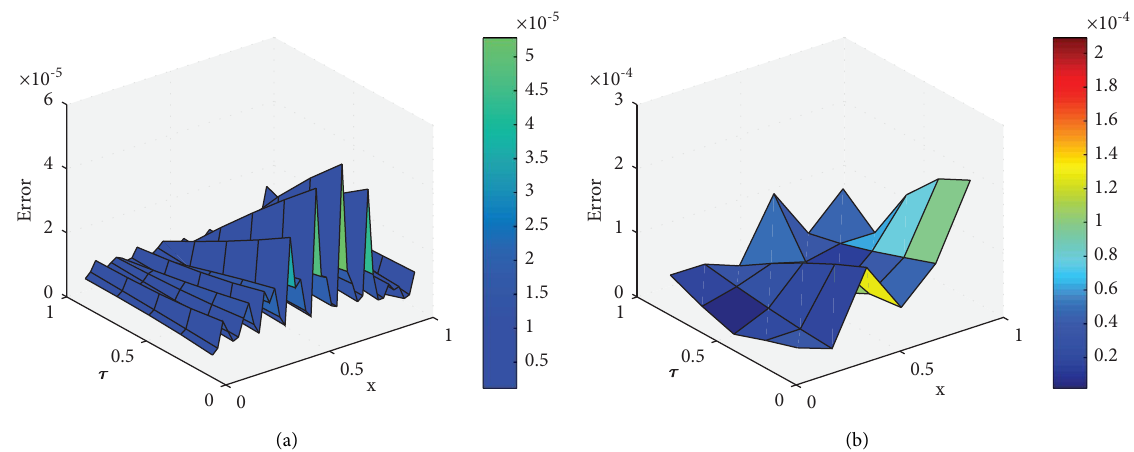
Figure 9: (a) Absolute error at k � 4, M � 5 and (b) absolute error at k � 2, M � 4 of Example